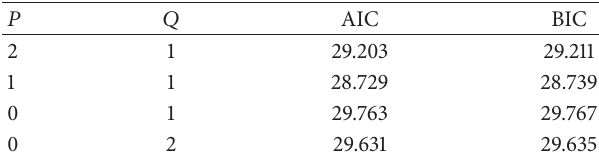
Table 3: Comparison of AIC and BIC values.